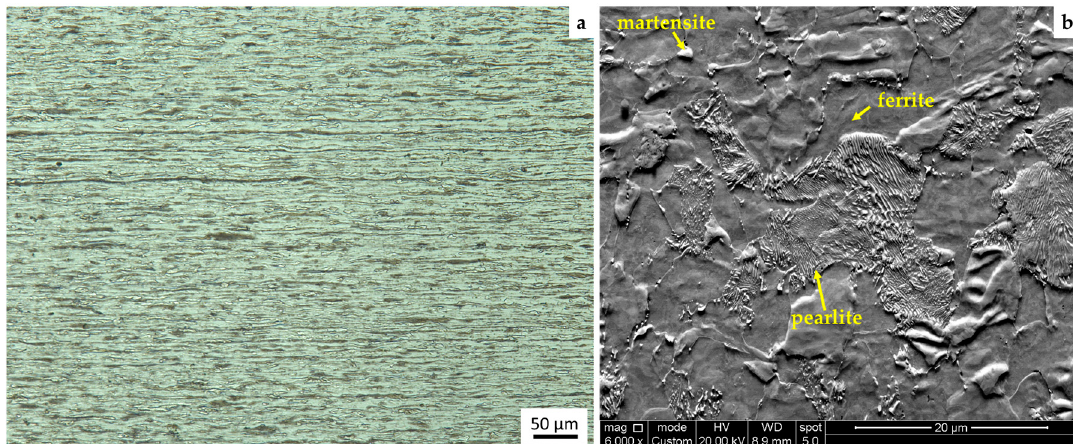
Figure 1. The parameters of both applied heat treatments. The conventional heat treatment (CH) consisted of a heating with rate of 10 °C/s to the peak temperature followed by quenching, while the heating rate of the ultra-fast heat treatment (UFH) was 780 °C/s. For both treatments, the isothermal soaking time was 0.2 s.